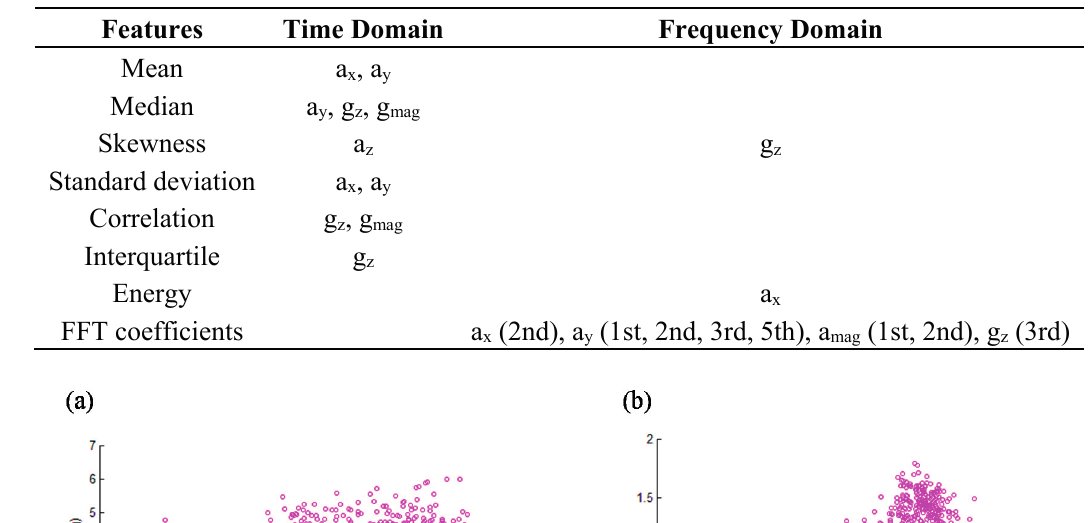
Table 2. SVM selected features.